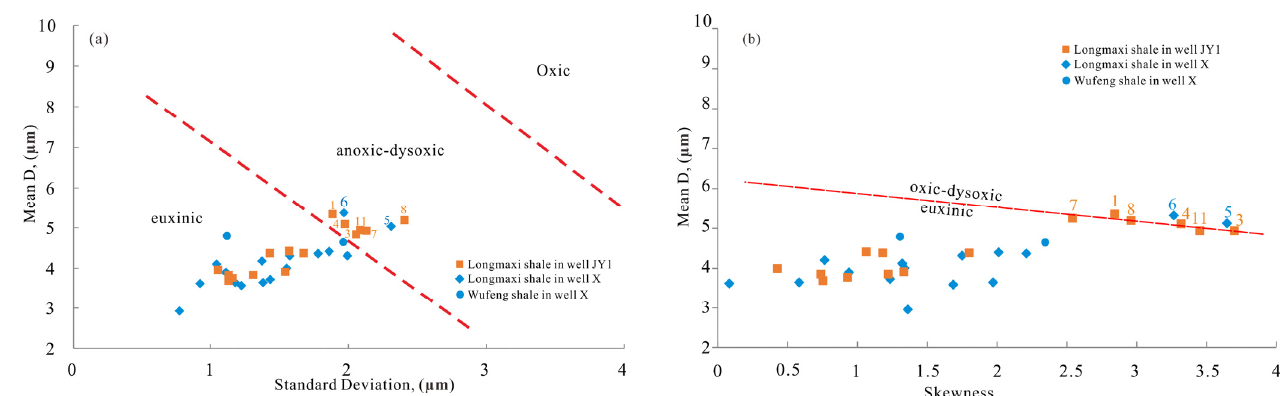
Figure 6. ( a ) Plot of the mean versus the standard deviation of the framboid size distribution of two wells. Dashed lines at the euxinic–anoxic boundary and the dysoxic–oxic boundary are from Wilkin et al. (1996) [11] and Chang et al. (2009) [45]; ( b ) plot of the mean versus the skewness of the framboid size distribution of two wells. The dashed line is from Wilkin et al. (1996) [11].